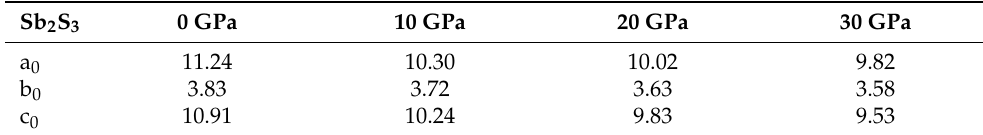
Table A1. Theoretical estimation (PBEsol) of the lattice parameters of the Sb 2 S 3 compound, for the Pnma structural phase, for different pressure values, at which the system is both energetically and dynamically stable (presented in units of Å).